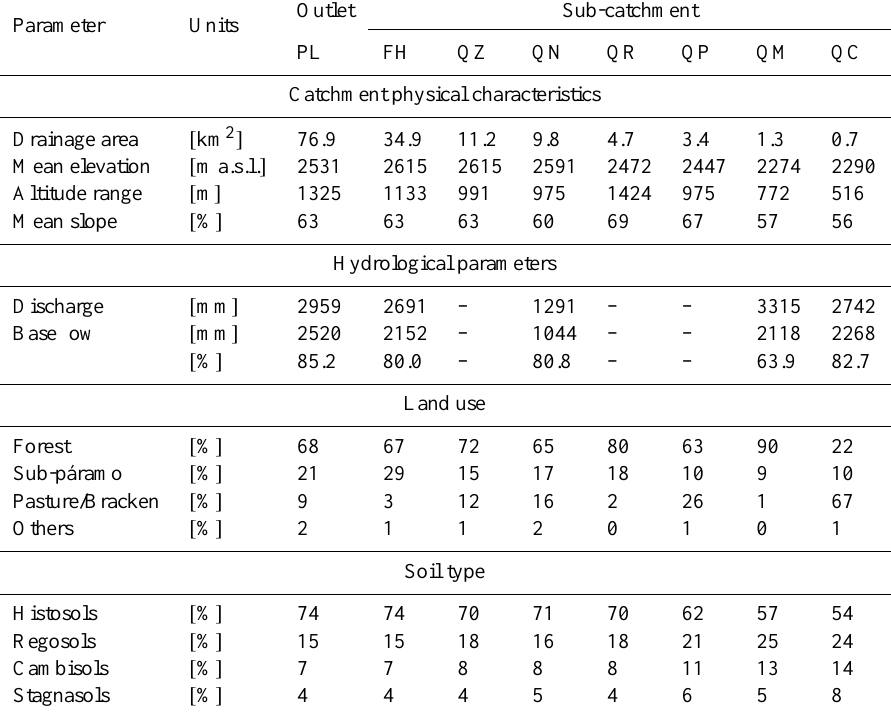
Table 1. Main characteristics of the San Francisco catchment and its tributaries. Acronyms of sampled sites are defined in Table 2.